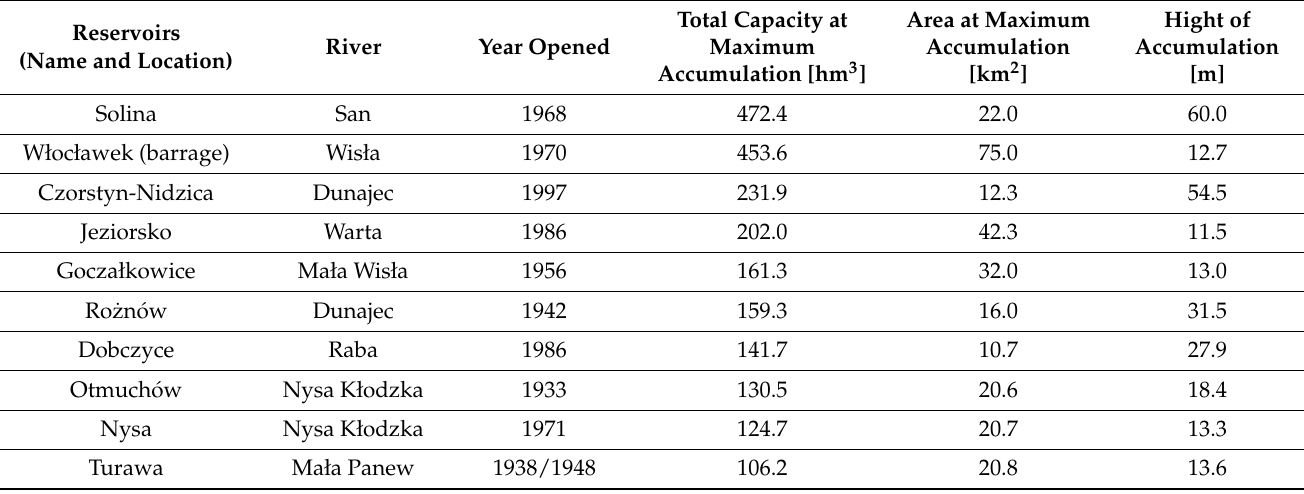
Table 7. Parameters of reservoirs in